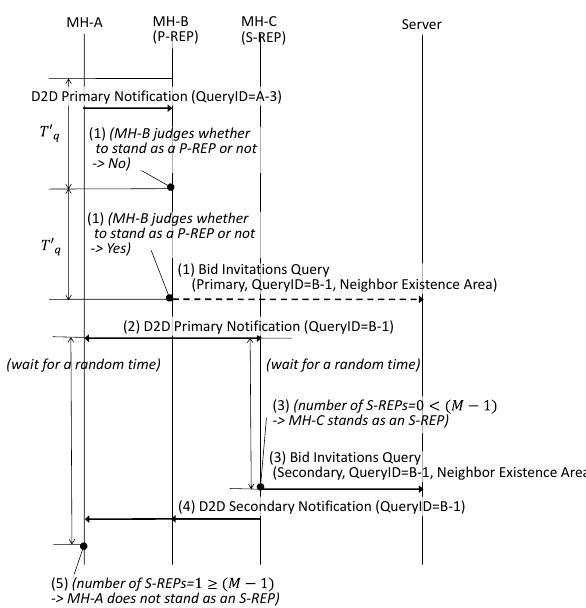
Figure 14. Example of the selection of a P-REP and S-REPs (in the case of 𝑀 = 2 ).